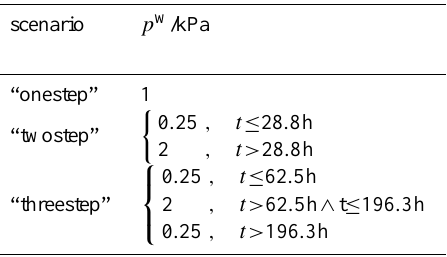
Table 2. The different boundary condition scenarios used in the simulations. All simulations were simulated isothermally at T = 293K and carried out until t = 550h.